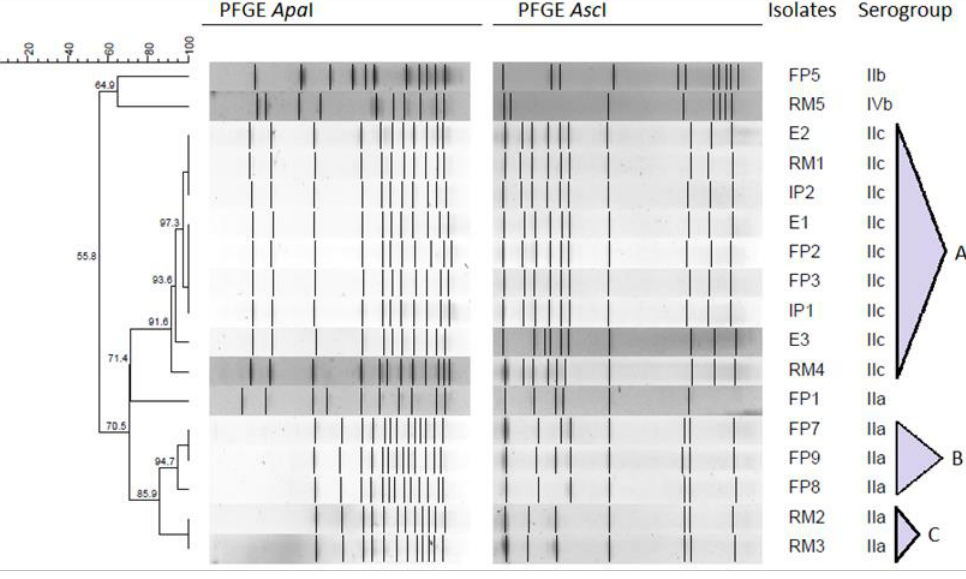
Figure 1. Dendrogram of the Apa I- Asc I PFGE profiles and corresponding serogroup for 17 L. monocytogenes selected isolates.